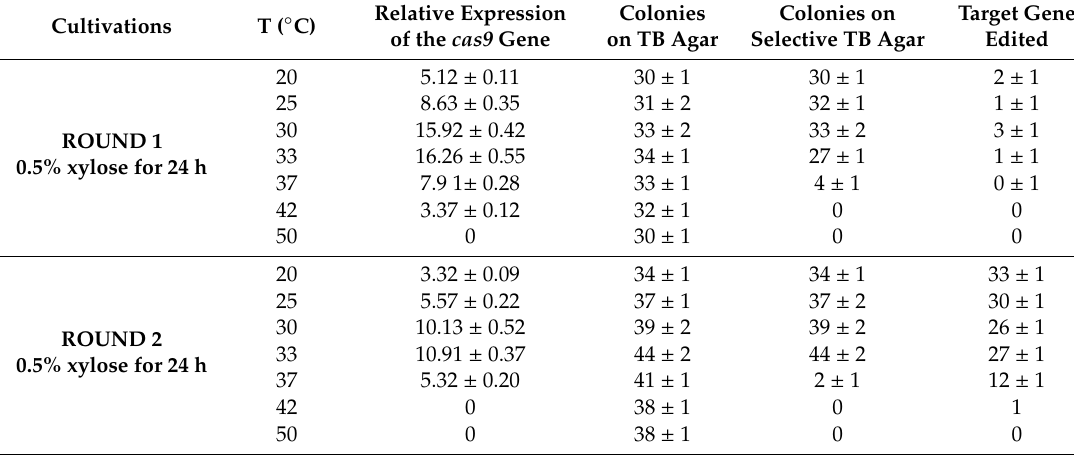
Table 4. E ff ect of temperature on gene expression, Cas9 protein activity, and thermosensitive replication of the plasmid in the conditional clustered regularly interspaced short palindromic repeat (CRISPR) / Cas9 system-guided genome editing process 1